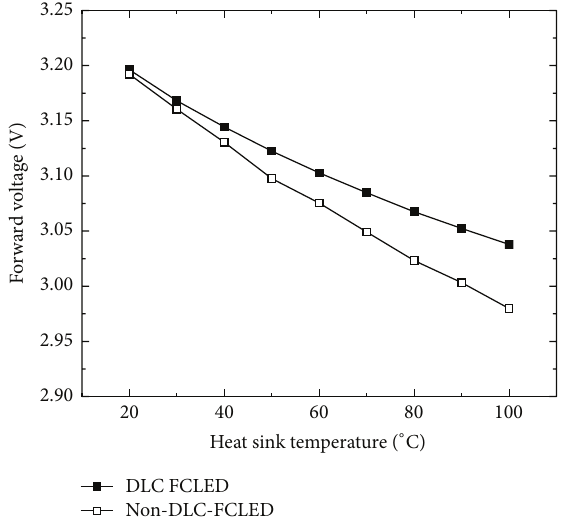
Figure4:Junctiontemperatureasafunctionoftheinjectioncurrent for the DLC-FCLED and the non-DLC-FCLED.